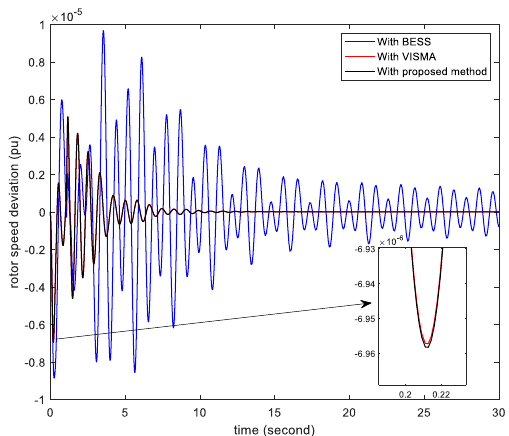
Figure 11. Rotor speed responses of G4.